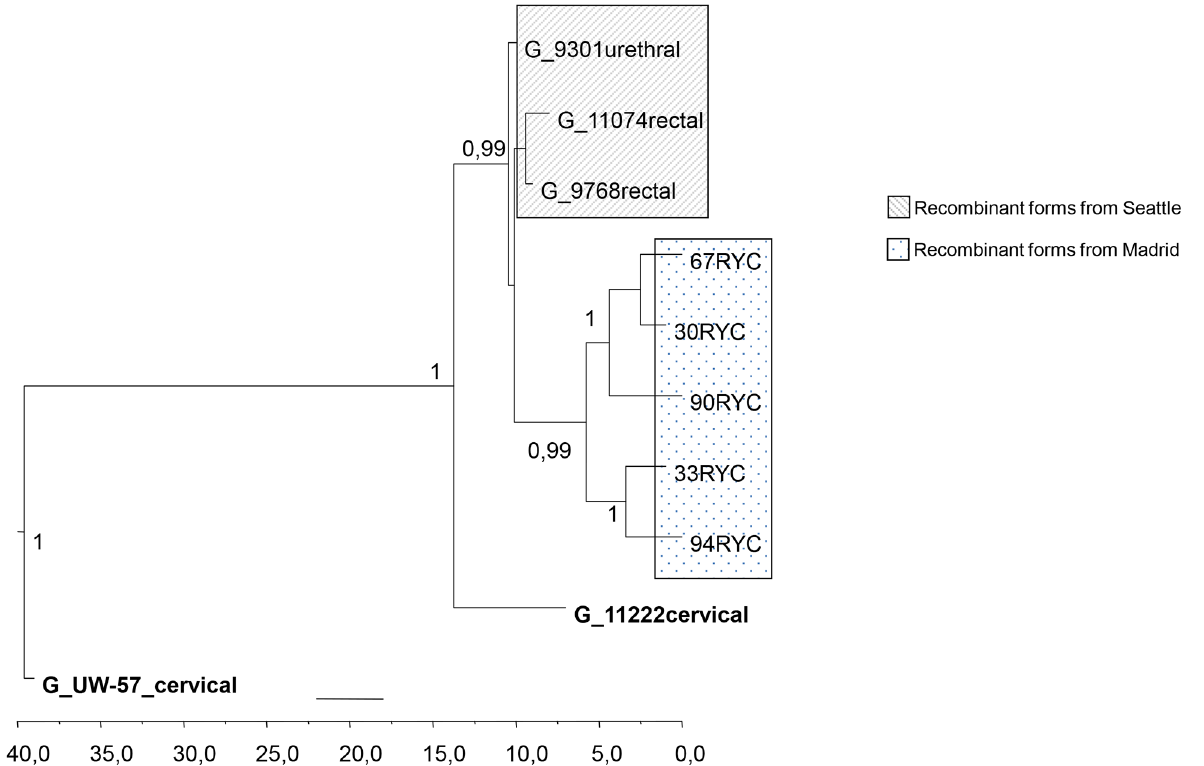
Fig 4. Bayesian analysis (BEAST software) of concatenated rs2-tarP-incEF-pmpH genes, using Seattle and Madrid strains belonging to G genotype. The general time reversible plus proportion of invariable sites (GTR+ I) for rs gene, Hasegawa-Kishino-Yano, plus proportion of invariable sites (HKY+ I) for inc genes and HKY for tarP and pmpH genes. Numbers indicate posterior probability ( >